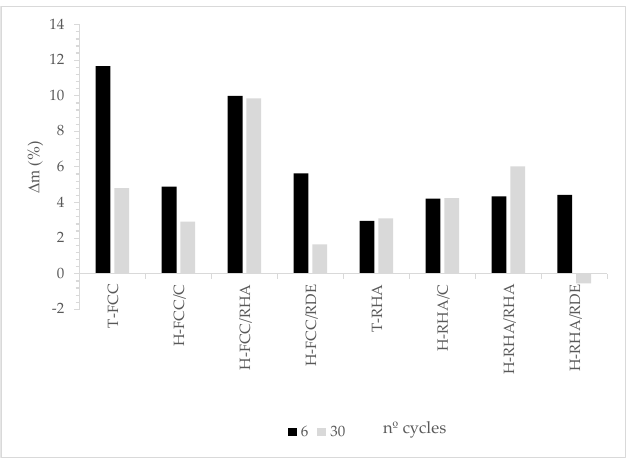
Figure 4. Mass variation ( ∆ m, %) of all the assessed systems after the 6th and 30th freeze–thaw cycles.